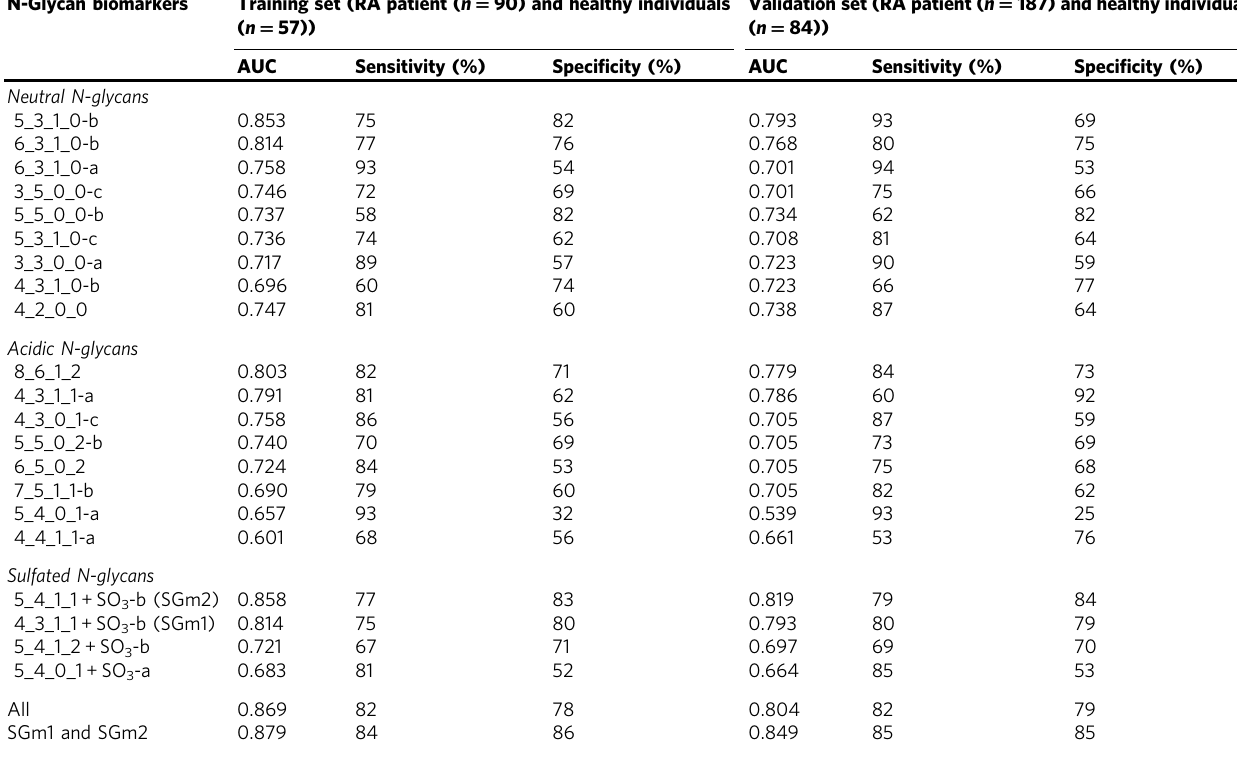
Table 1 Capacities of 21 N-glycan biomarkers for the classi fi cation of RA patients and healthy individuals N-Glycan